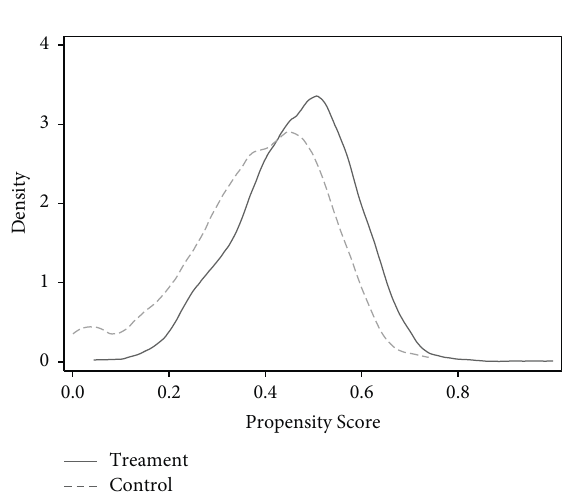
Figure 1: Before propensity score matching.